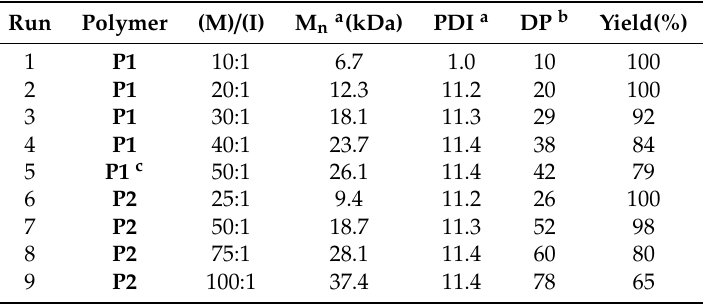
Table 1. Polymerization Data for the Resultant Polymers.